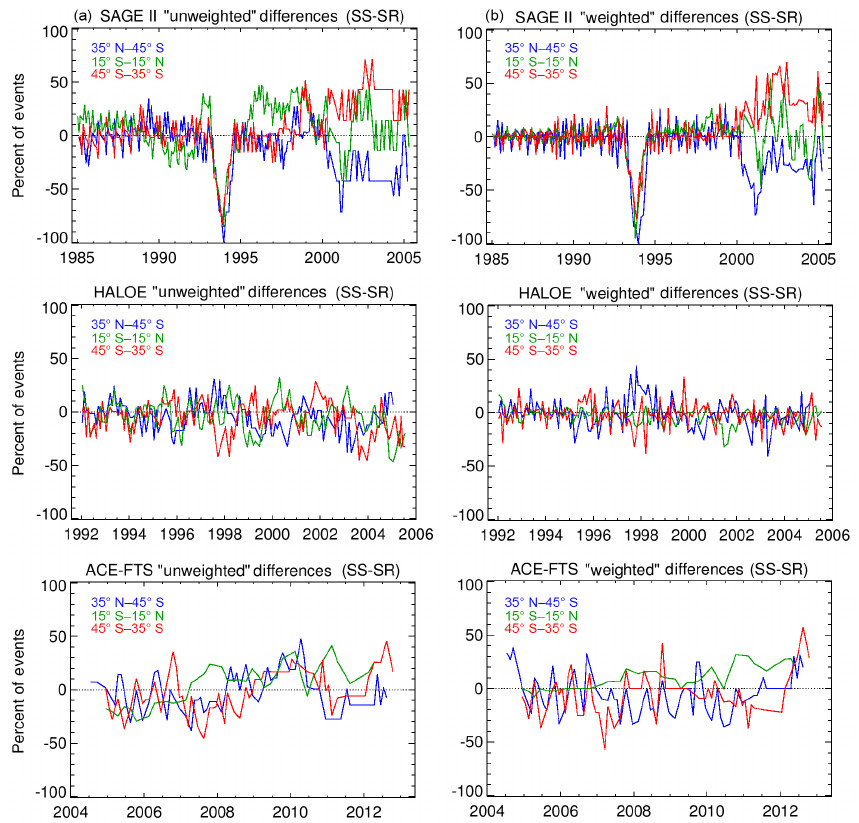
Figure 9. Long-term evolution of the diurnal sampling bias for three different data sets. The wider latitude bins are representative of data from Fig. 8. To remove the influence of the rapid monthly variability, the data are smoothed over 12 months and converted to a percent of total events. The left column first converts differences in total number of SR and SS events to percentages and then smooths, while the right column first smooths differences in number of events and then converts to a